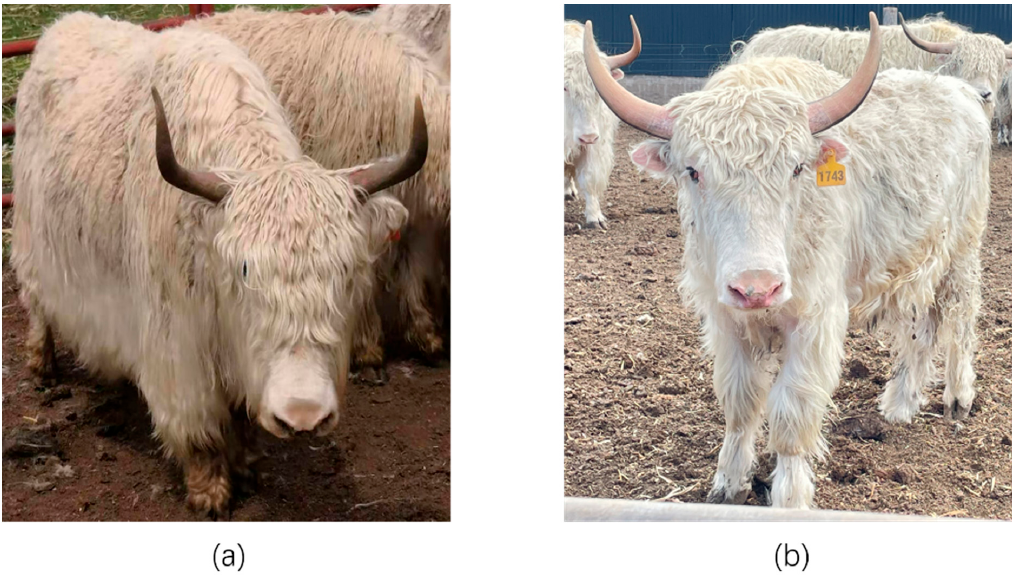
Figure 1. ( a ) Long-haired Tianzhu white yak; ( b ) Normal-haired Tianzhu white yak.